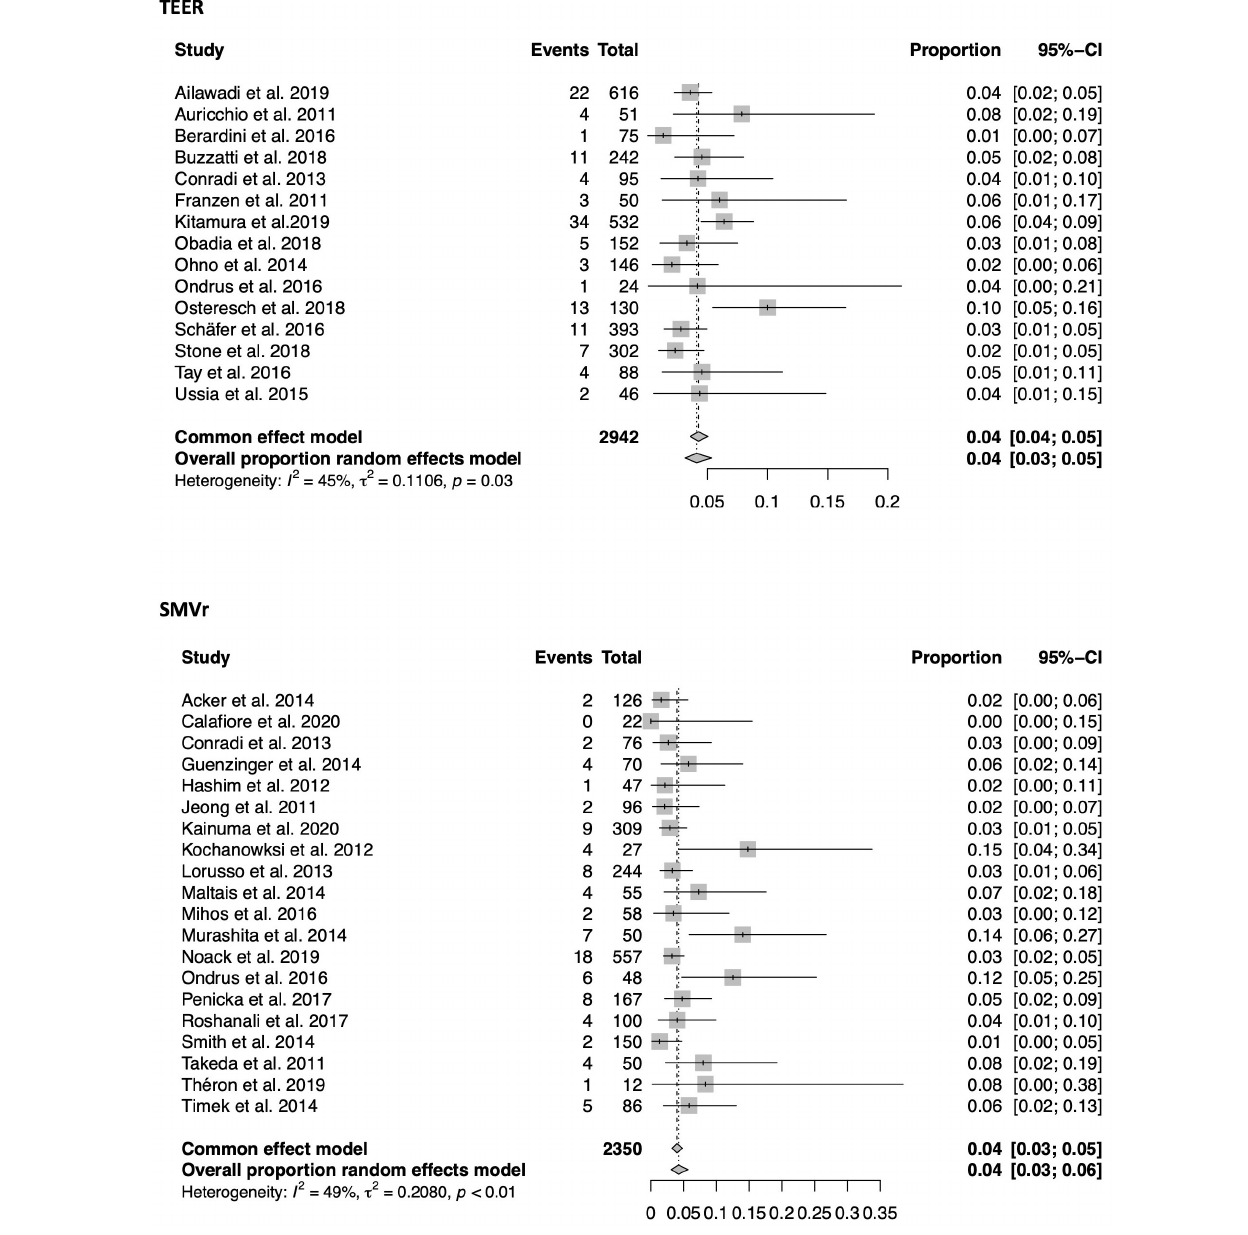
(95%-CI 1.52–1.97, I 2 = 99%) vs. 2.08 (1.57–2.59, I 2 = 99%); see